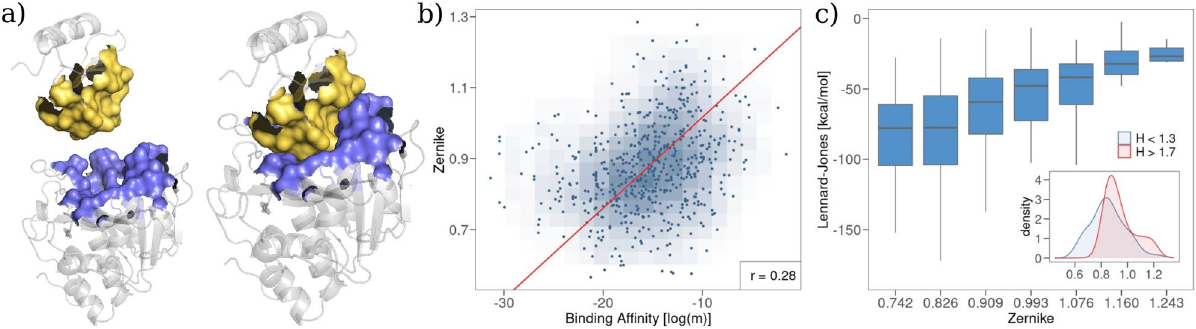
Figure 4. Comparison between shape complementarity and complex binding affinity. ( a ) Cartoon representation of the molecular surface of the binding region for a protein–protein complex (PDB id: 1TM1). ( b ) Minimum Zernike distance between the molecular surfaces of the binding regions as a function of the experimental binding affinity. ( c ) Box plot representation of the distributions of the total Lennard-Jones energy for different ranges of Zernike minimum distance. The inset reports the distributions of the Zernike values for the complexes whose binding region is mainly hydrophobic ( H < 1.3 ) and mainly hydrophilic ( H > 1.7